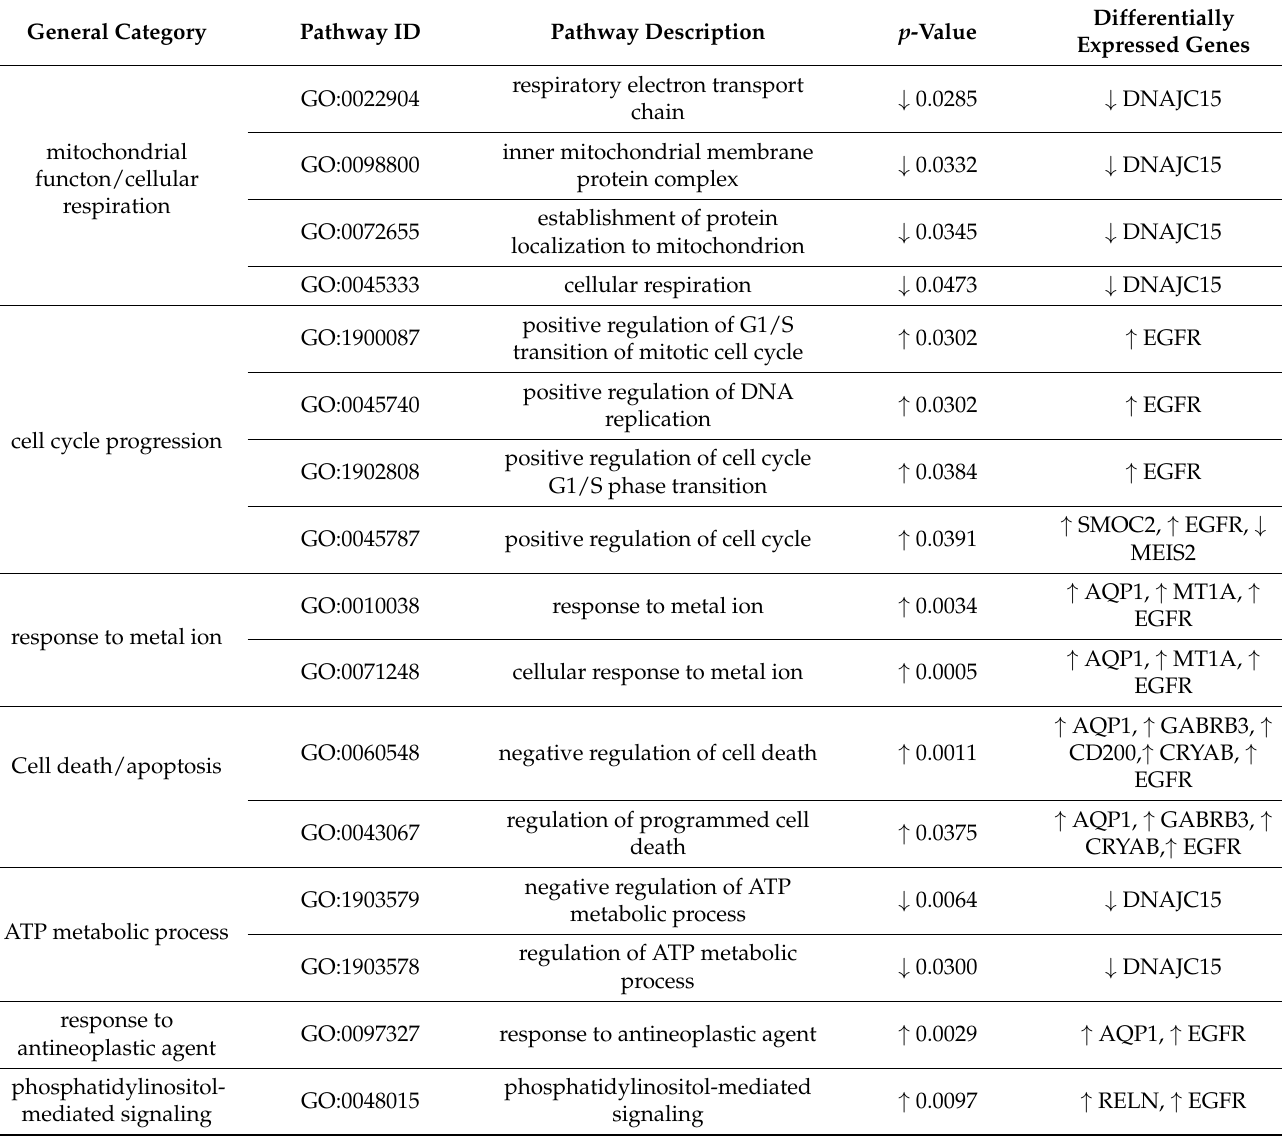
Table 1. Pathway analysis of genes differentially expressed between the resistant (1226 and 1254) and sensitive (2238, 2326, 1236, 1267) organoid models. Gene ontology IDs are listed under pathway